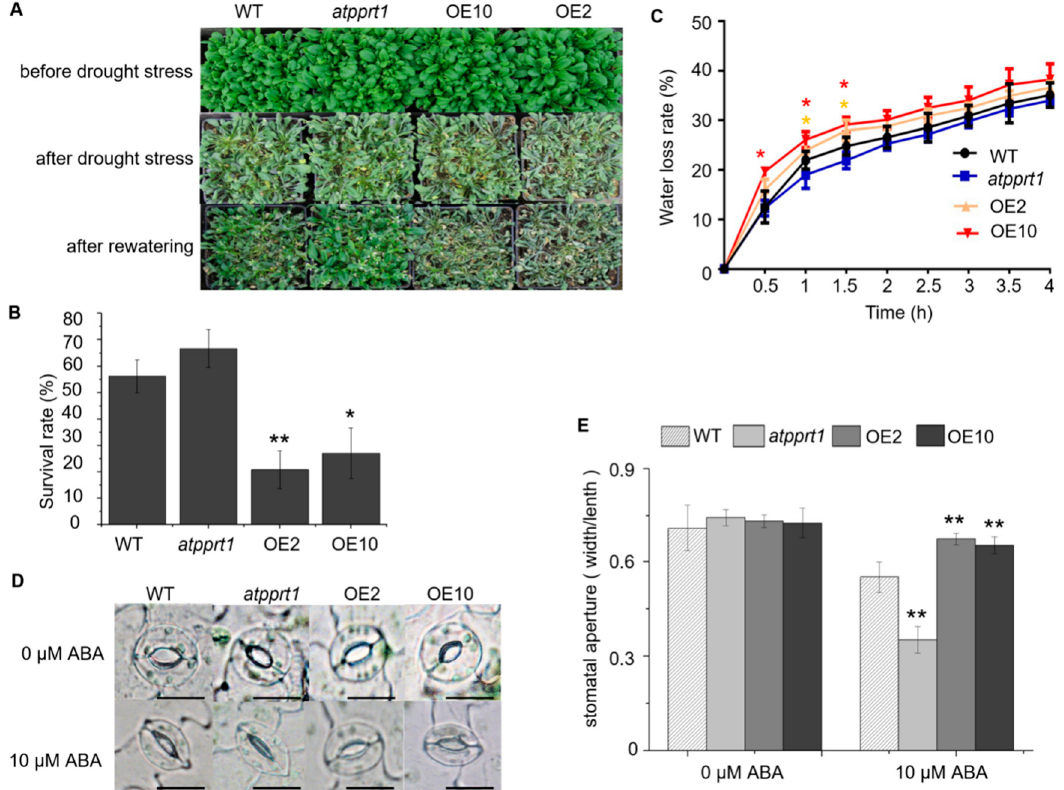
Figure 5. AtPPRT1 negatively regulates drought stress response in Arabidopsis. ( A , B ) Phenotype and survival rates of WT, atpprt1 , OE2, and OE10. Whole plants were subjected to drought stress for 13 days and then re-watered. Photos were taken 2 days after re-watering. Error bars represent ± SD ( n = 3, * p < 0.05 and ** p < 0.01, t -test); ( C ) The water loss rates of WT, atpprt1 , OE2, and OE10 under dehydration condition. Detached leaves from mature plants, exposed to air at room temperature and same humidity conditions, were weighed every 30 min; ( D ) Analysis of ABA-mediated stomatal closure. Detached leaves from mature plants were treated with or without 10 µ M ABA for 2 h. Stomatal apertures were photographed using a fluorescence microscope (DMI6000B, Leica, Wetzlar, Germany); ( E ) Length/width ratios of stomas were measured and calculated using Image J. Bars represent 10 µ m. The values are the average of three individual biological replications. Error bars represent ± SD ( n = 100, * p < 0.05 and ** p < 0.01, t -test).